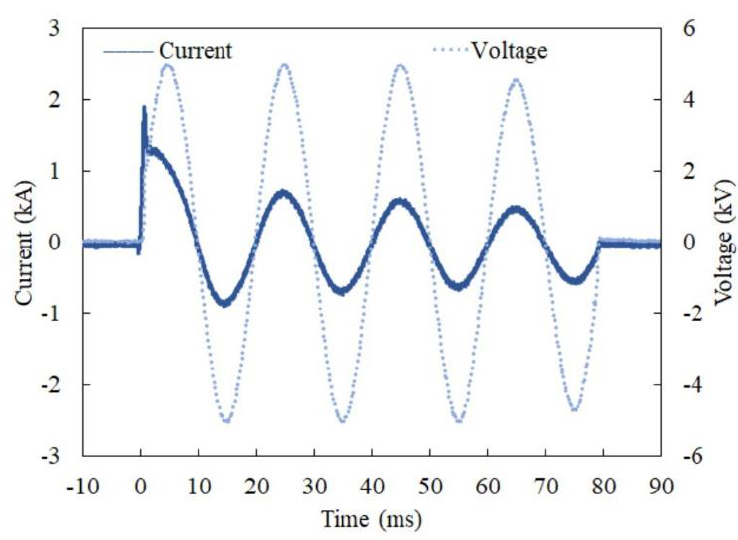
Figure 6. Voltage across the SFCL and current courses during short-circuit test at 72 K.